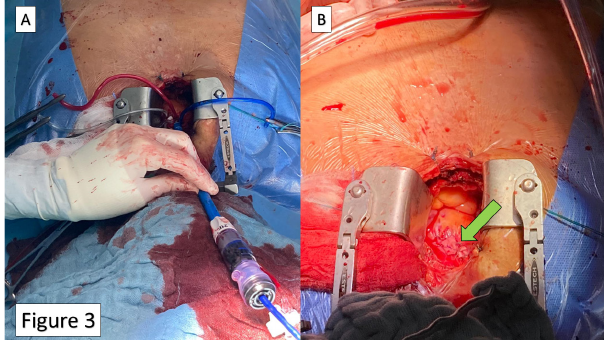
Fig. 3 - (A) Delivery sheath in place. (B) Final result after sutures tightening (green